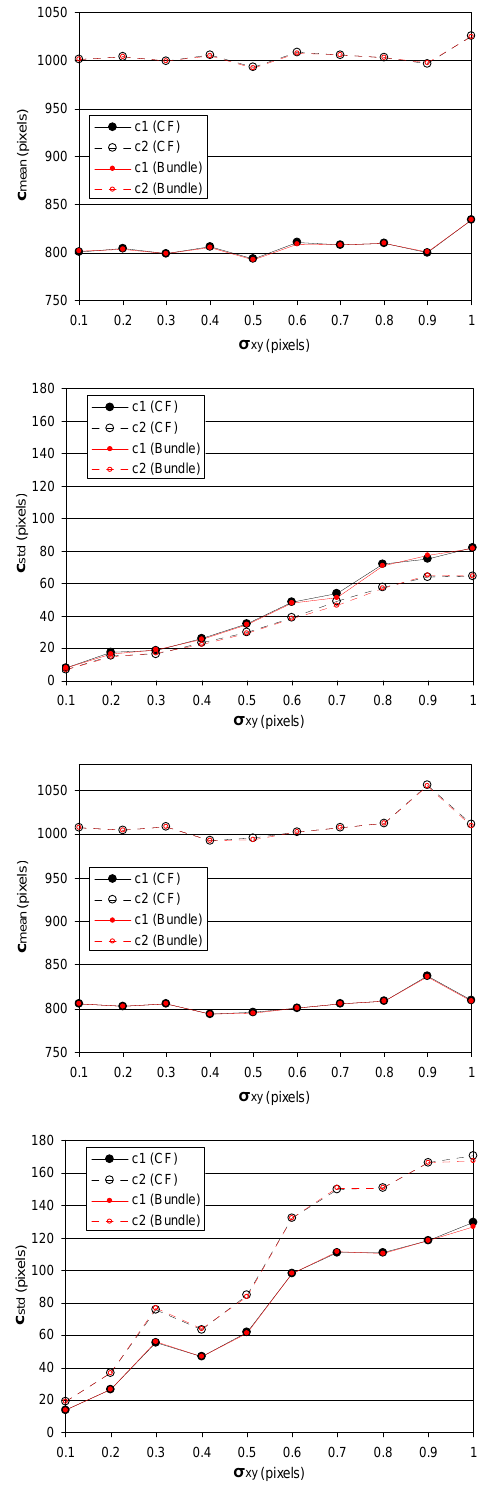
Figure 6. Comparison of different algorithms for the computation of two camera constant values from two simulated configurations (configuration 1 above, configuration 2 below) at different noise levels. Mean values and standard deviations are given from 20 solutions per noise